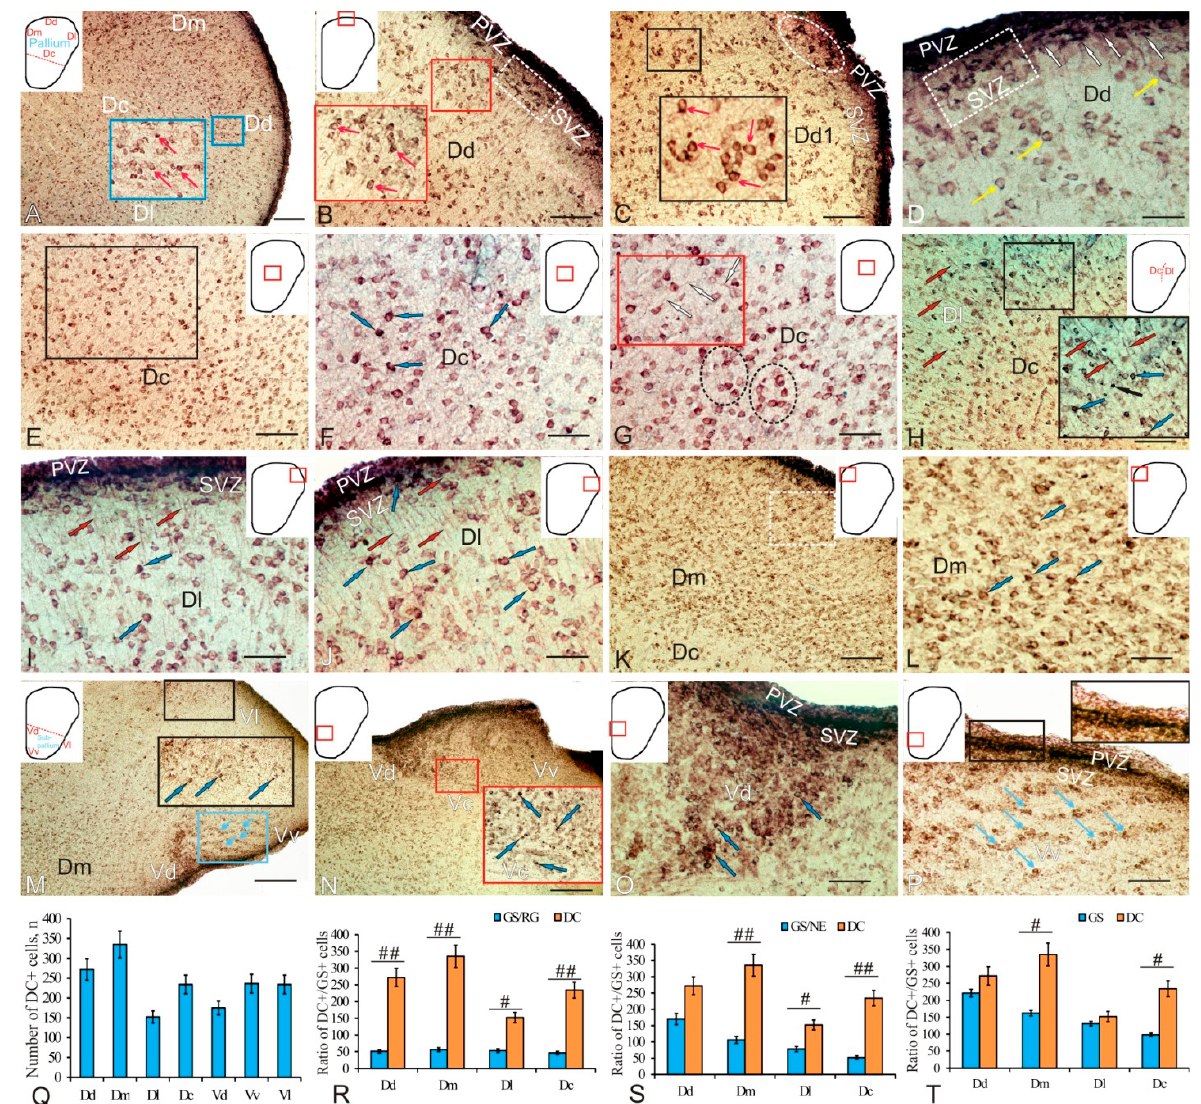
Figure 3. Doublecortin (DC) in the pallial and subpallial regions in the telencephalon of trout, Oncorhynchus mykiss : ( A ) a general view of DC immunolocalization patterns in the trout pallium (Dd—dorsal, Dm—medial, Dl—lateral, and Dc—central zones of pallium), the pictogram showing the zones of the dorsal telencephalon (pallium), with the dotted line separating the pallium from the subpallium, aggregations of DC+ cells, and intensely labeled cells (red arrows) in Dd (inset in blue rectangle); ( B ) a Dd fragment at a higher magnification, dense conglomerates of cells (in white dotted rectangle) with granular DC labeling detected in the SVZ, and diffuse clusters (red inset) of uniformly labeled cells (pink arrows) revealed in the PZ; ( C ) a fragment of Dd1 containing moderately labeled DC cells (inset) and intensely labeled cells located in the apical part of the SVZ (white dashed oval); ( D ) various types of DC+ cells of the dorsal pallium, undifferentiated intensely labeled cells (white arrows), a cluster with intensely and moderately labeled cells in the SVZ (in white dotted rectangle), and later stages of neuronal differentiation of weakly DC labeled oval and elongated cells (yellow arrows); ( E ) DC immunolocalization in the central zone of Dc pallium; ( F ) an area of E at a higher magnification (in black rectangle), with intensely and moderately DC+ labeled cells (blue arrows); ( G ) diffuse (in red rectangle) and cluster (in black dotted ovals) pattern of distribution of DC+ cells in Dc with proximal areas of neuroblast processes (white arrows); ( H ) DC+ cells at the border between Dc and Dl (inset), intensely labeled cells (black arrows), moderate (blue arrows), and RG fibers (red arrows); ( I ) DC immunolocalization in the lateral zone of the pallium (Dl); ( J ) the cluster pattern of distribution of DC+ cells in Dl (designation as in ( H )); ( K ) DC immunolocalization in the medial (Dm) zone of the pallium at the border with Dc; ( L ) a fragment of ( K ) at a higher magnification (in white dotted rectangle) with DC+ cells (blue arrows); ( M ) a general view of DC